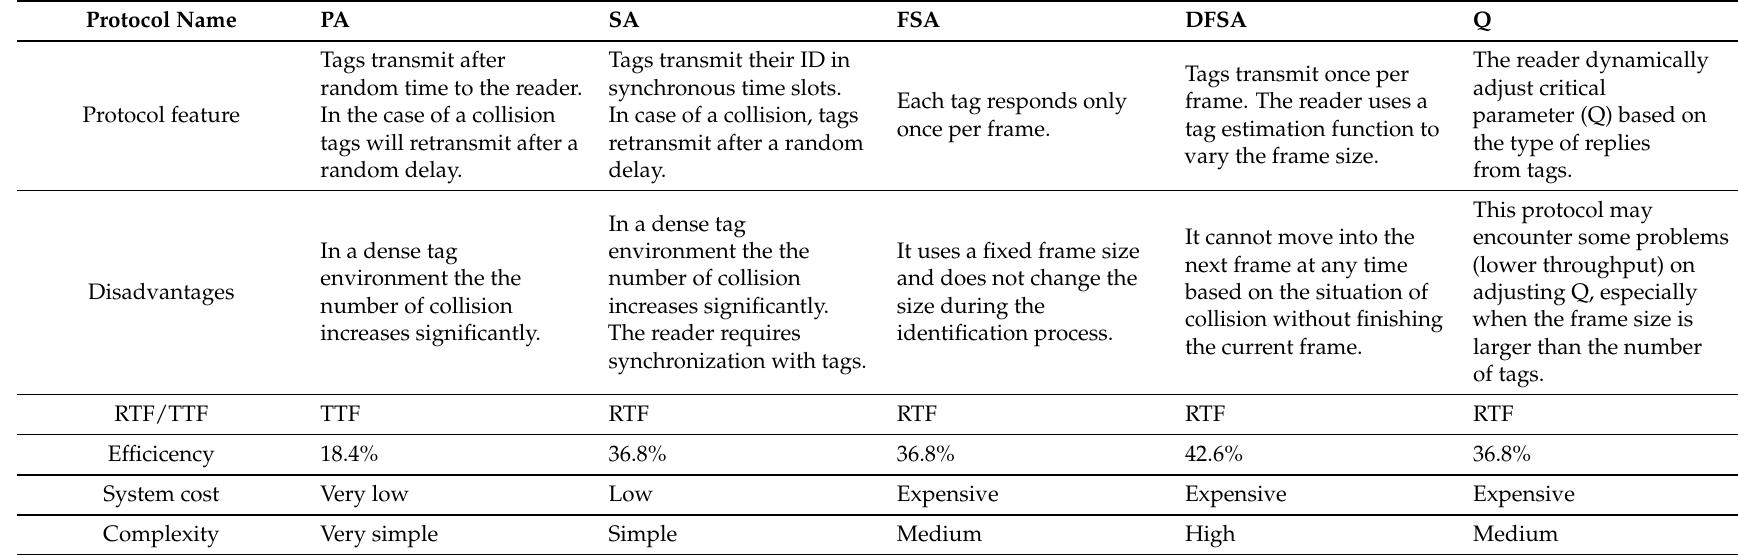
Table 1. A comparison of Aloha